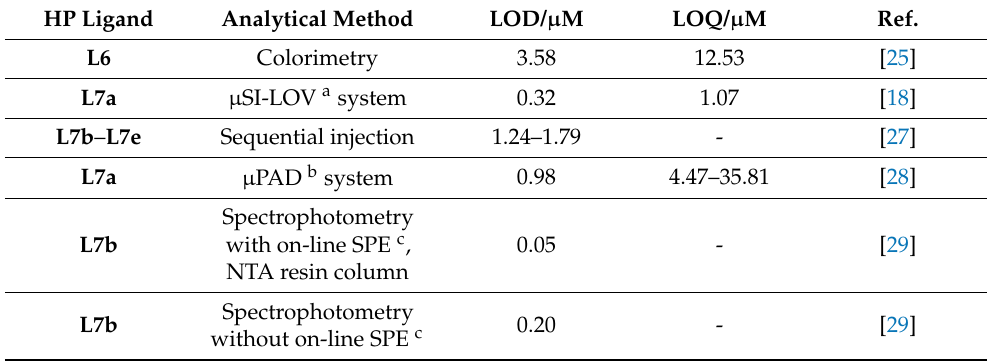
Table 2. LOD and LOQ values determined using hydroxypyridinone ligands for Fe 3+